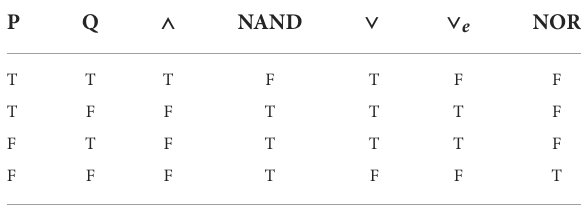
TABLE 1 Logic’s truth